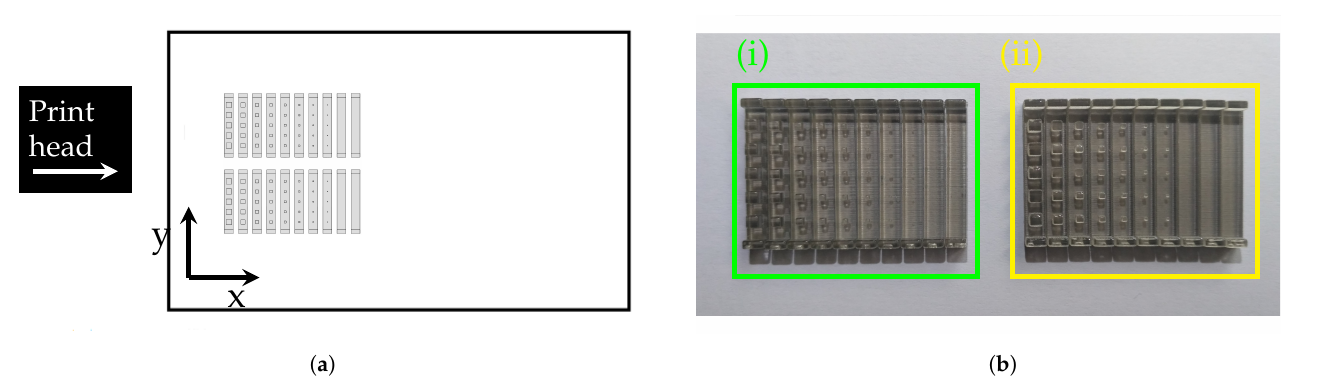
Figure 3. Polyjet tray showing the STs’ positing; ( a ) (Ph) Polyjet build orientation (i.e., printhead movement direction); ( b ) STs after support removal with highlight selection considered for analysis; ( i , ii ) specimens produced without and with support material, respectively.